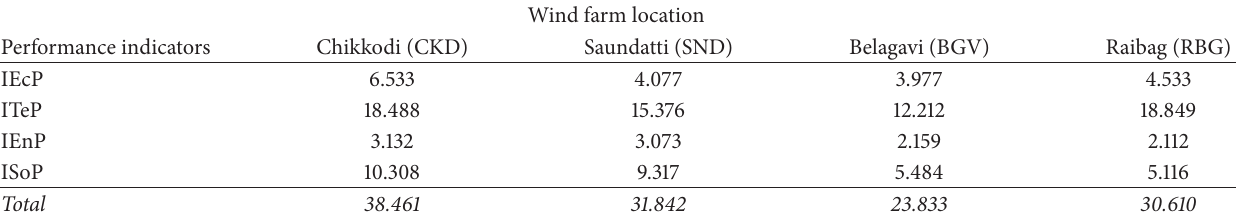
Table 7: Comparison of the wind farms based on